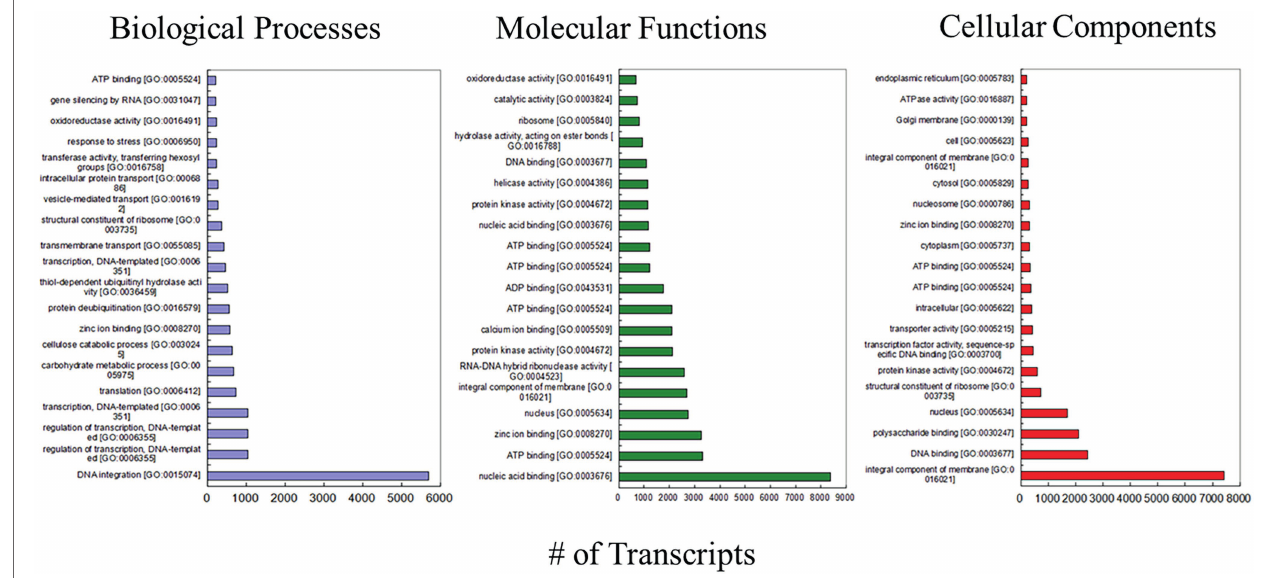
FIGURE 3 | Bar graph depicting gene ontology (GO) classification and enrichment of top 20 GO terms represented under biological (DNA integration: 5688 transcripts), molecular (nucleic acid binding: 8379 transcripts), and cellular components (an integral component of membrane: 7433).